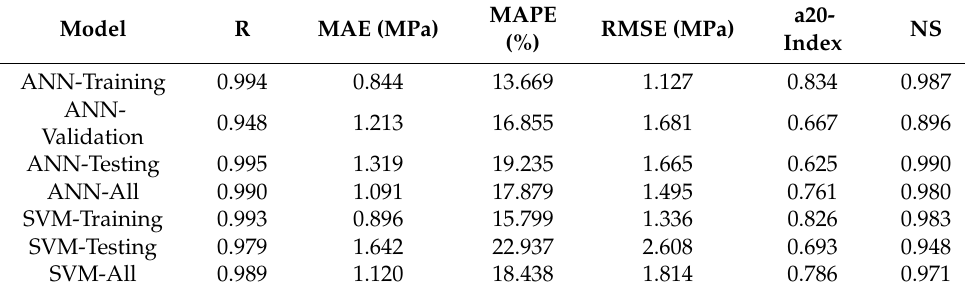
Table 6. Results of proposed ANN